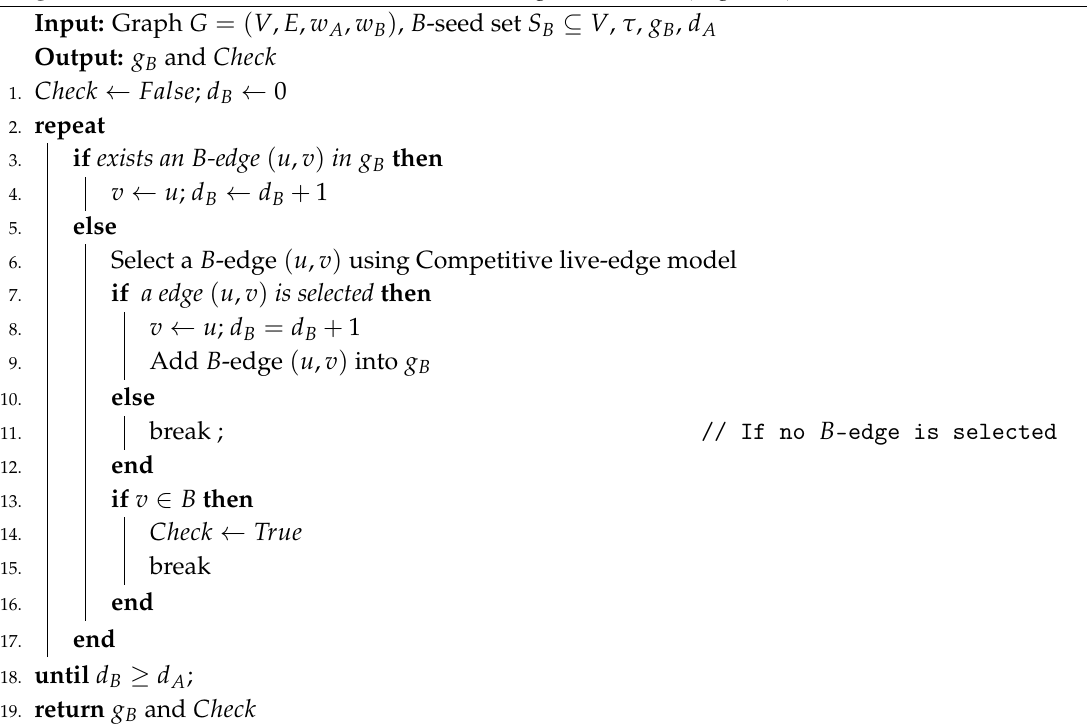
Algorithm 2: Check the distance from u to B on g B — CheckBP ( u , g B , d A ) .